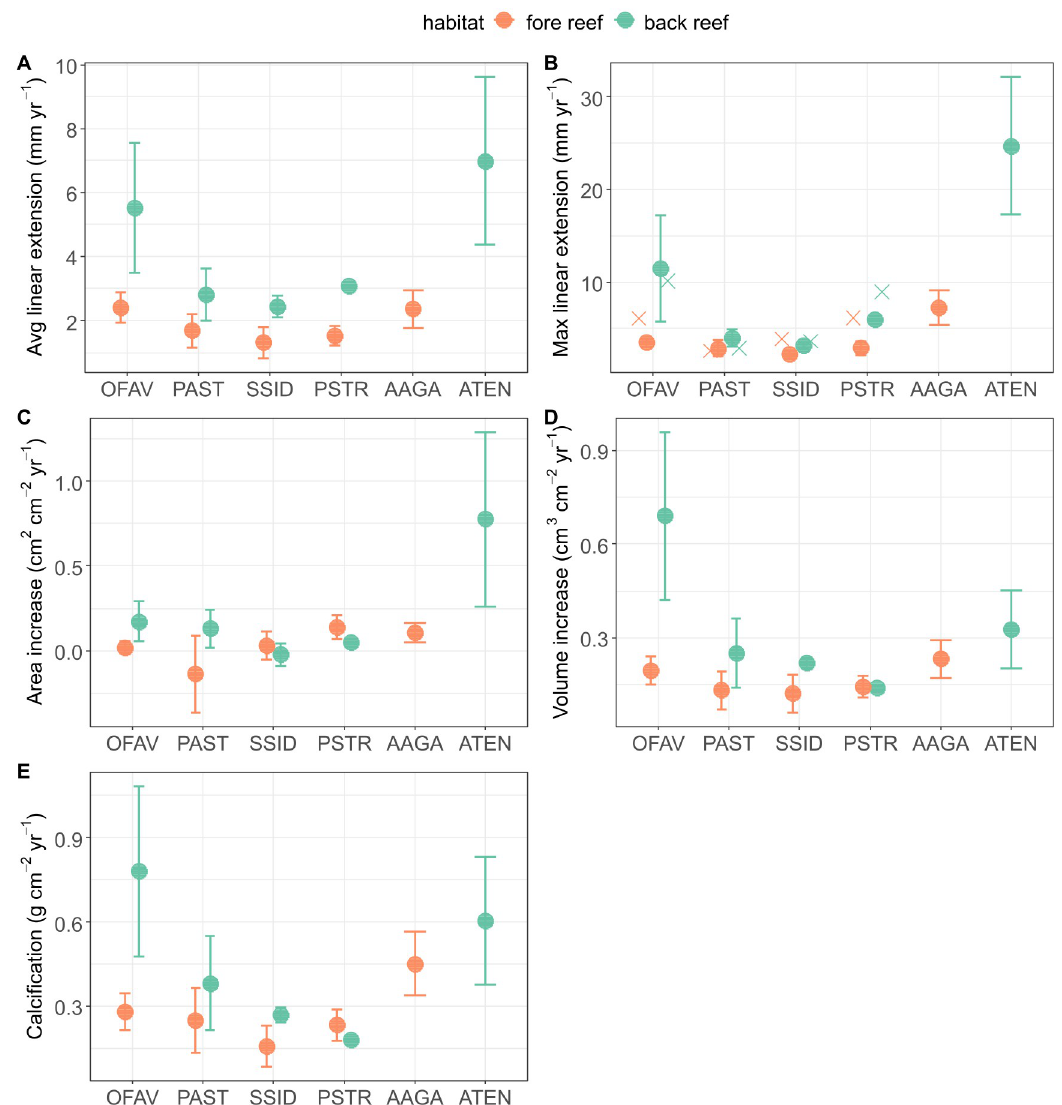
Fig 3. Colony-scale growth metrics (average ± SD) for six Mexican Caribbean coral species comparing two reef sites. Species: OFAV: Orbicella faveolata , PAST: Porites astreoides , SSID: Siderastrea siderea , PSTR: Pseudodiploria strigosa , AAGA: Agaricia agaricites and ATEN: Agaricia tenuifolia . Reef sites: Orange: Fore reef, green: Back reef. Panel B) additionally displays linear extension rates obtained by CT scanning of coral cores from the same sites (crosses; Medellı´n-Maldonado et al., in preparation).